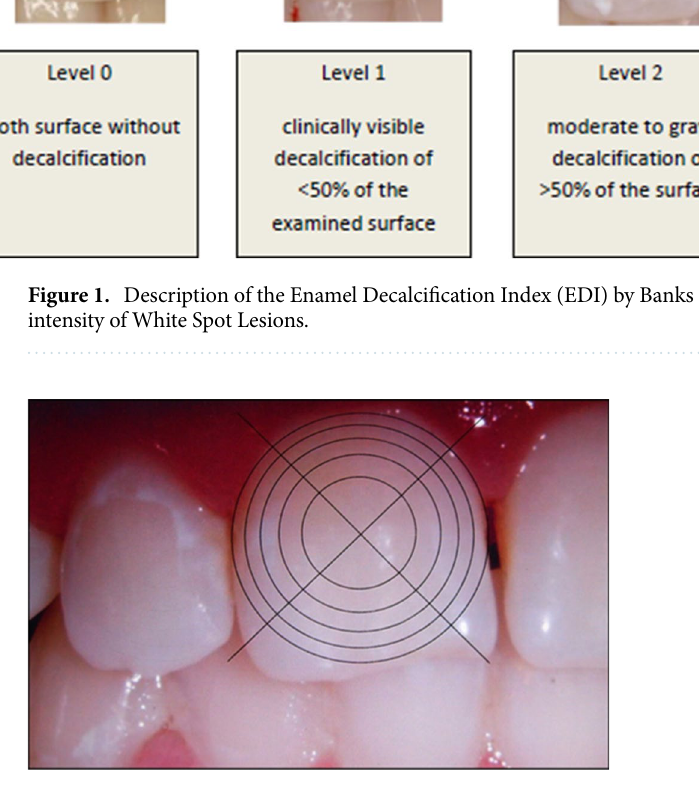
Figure 2. Evaluation tool with graticule and concentric